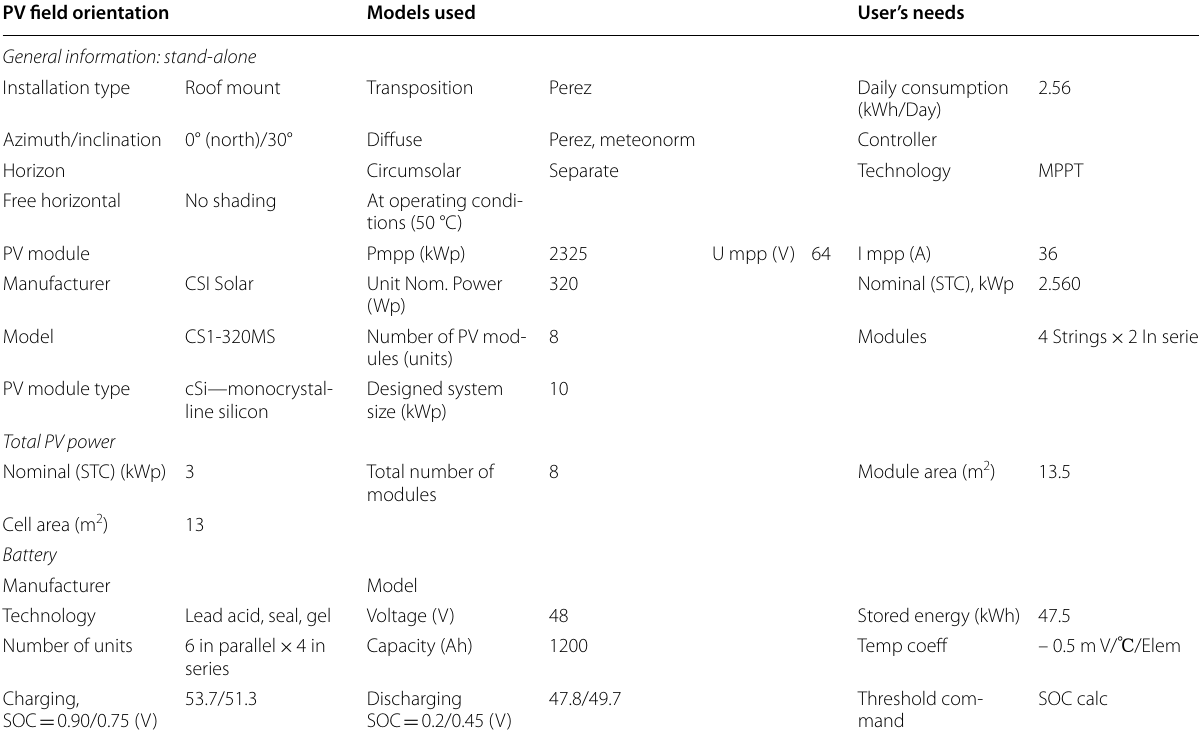
Here, STC is the standard test conditions; SOC is the state of charge estimating; Pmpp (kWp) is the power at maximum power point; Umpp (V) is the voltage at the maximum power point, and Impp is the actual amperage at MPPT